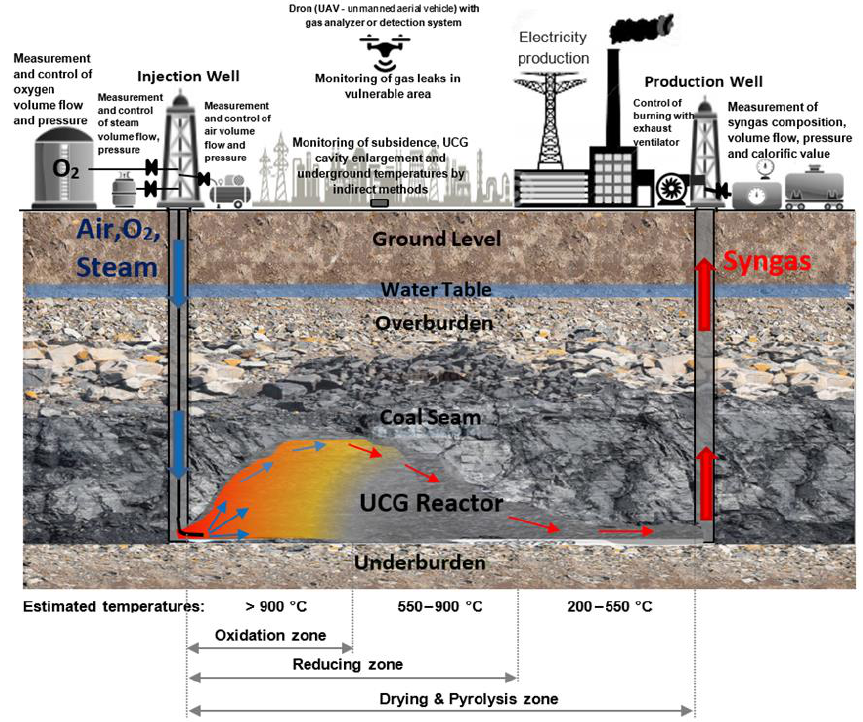
Figure 1. Principle of the UCG process